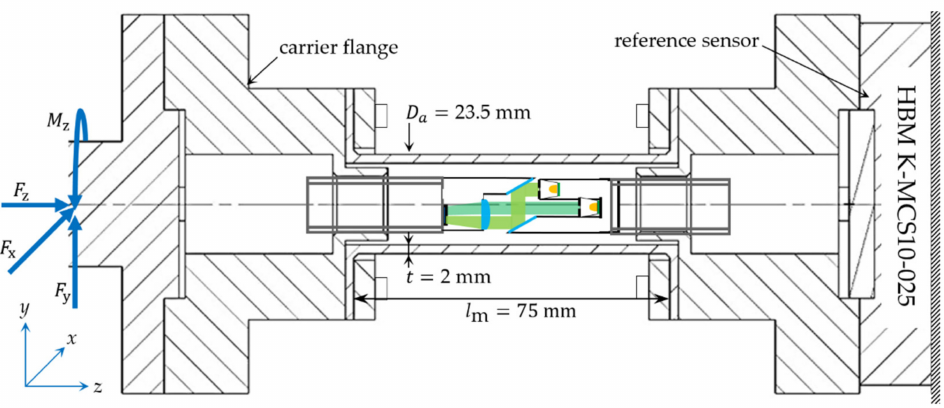
Figure 5. Design of the prototype used to evaluate the functional